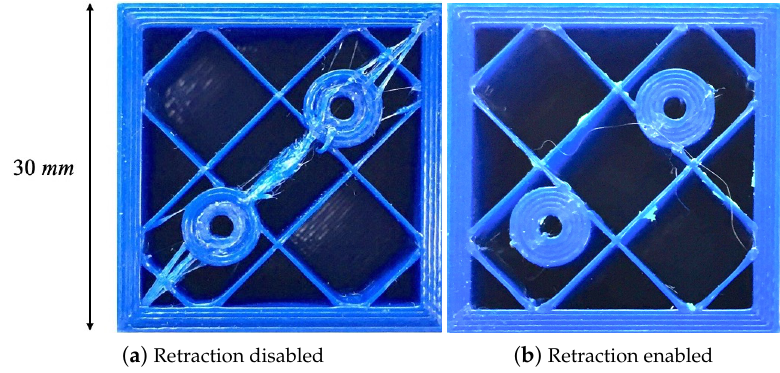
Figure 8. Influence of retraction settings on pressure